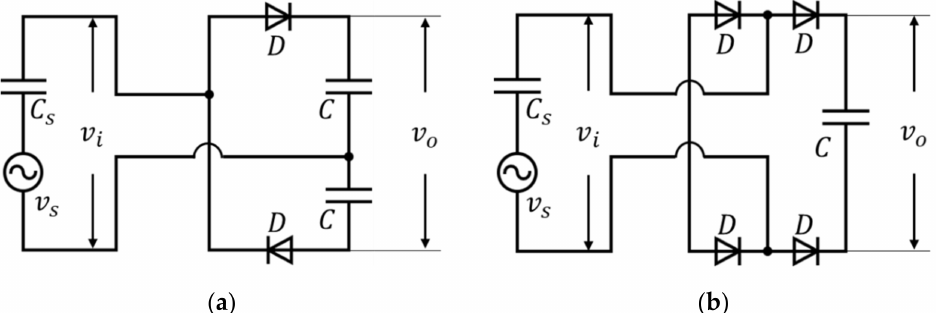
Figure 11. Rectifier circuits: ( a ) VDR; ( b ) FBR.